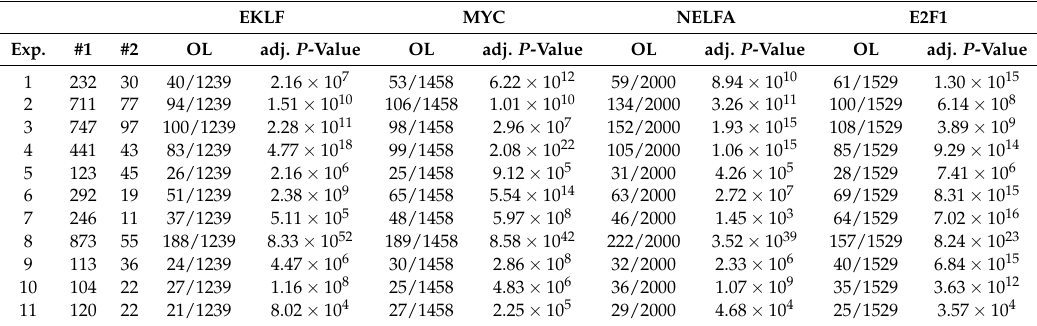
Table 3. In each of 11 experiments, 20 top-ranked significant TFs whose sets of target genes significantly overlap with the set of genes selected for each experiment were identified. Then, EKLF, MYC, NELFA, and E2F1 turned out to be among the 20 top-ranked significant TFs for all 11 experiments. EKLF MYC NELFA E2F1